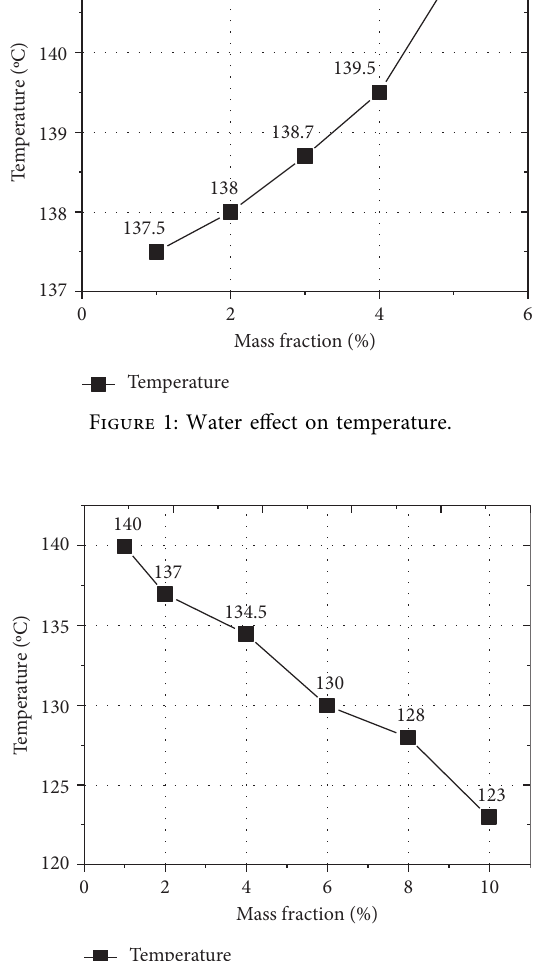
Figure 2: HCFC-141 b effect on temperature.